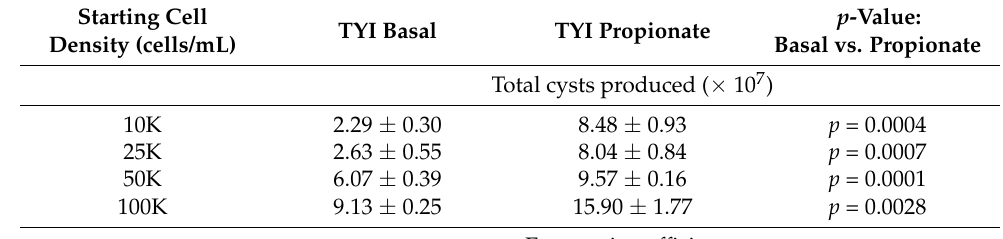
Table 1. Cyst production, encystation efficiency, and encystation rate. Starting Cell Density